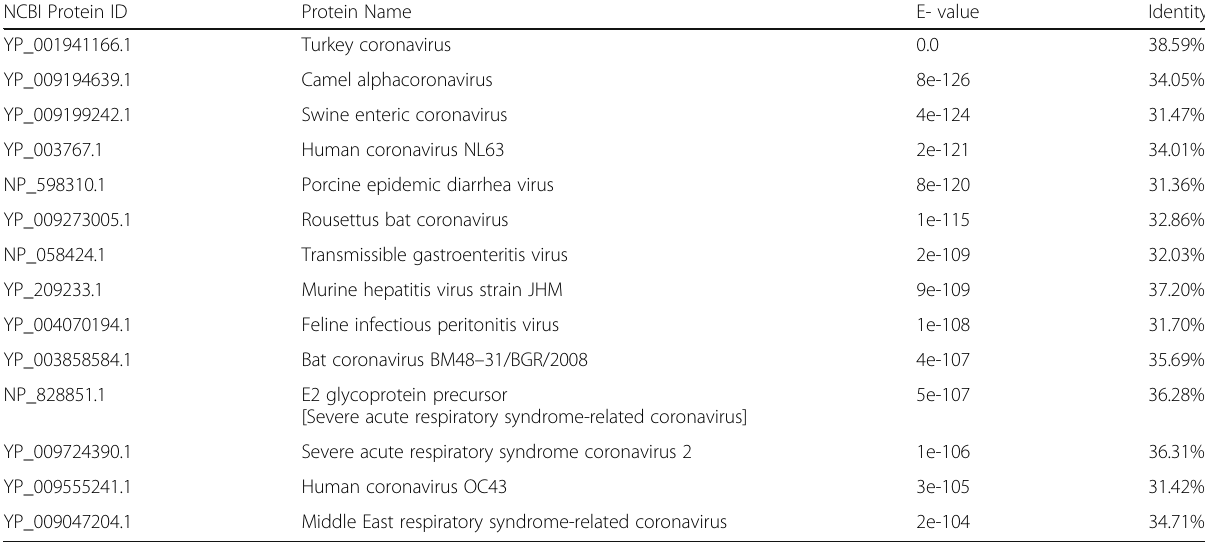
Table 2 Blastp similarity search of IBV against other coronaviruses in human and animals